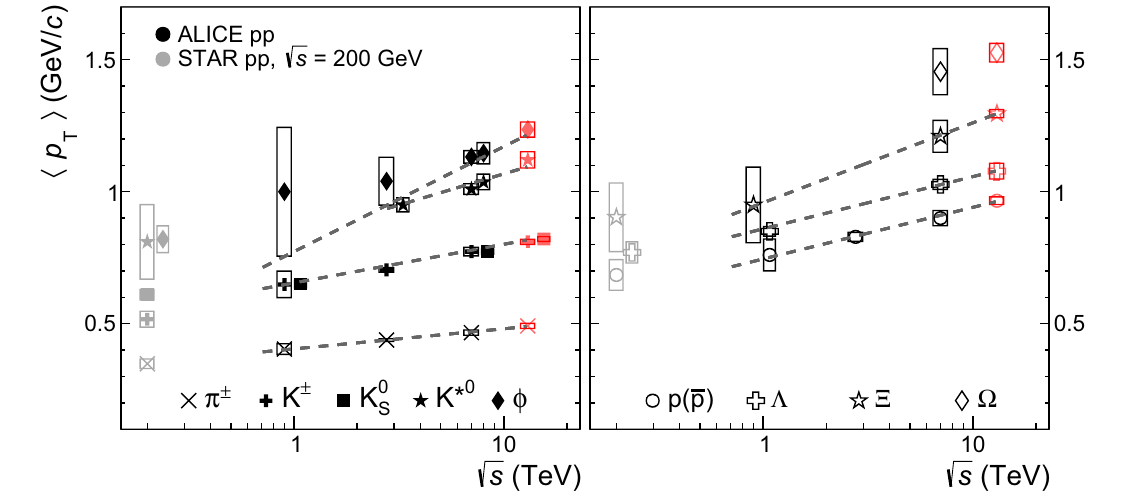
Fig. 10 Average transverse momentum (cid:10) p T (cid:11) as a function of the center-of-mass energy. Open boxes indicate the statistical and system- atic uncertainties (when available) summed in quadrature. Results from ALICE [7,24,26,27,51,58,60,63] are compared with those from STAR √ s = 200 GeV [88]. Some data points are slightly offset measured at